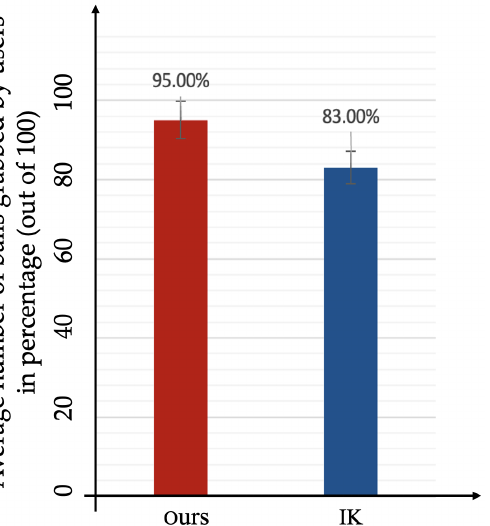
Figure 11. Questionnaire results in the archery game. Our proposed method and IK. Figure 14. Average of total balls grabbed by the users in percentage in the ball-grabbing game. Our proposed method and IK.